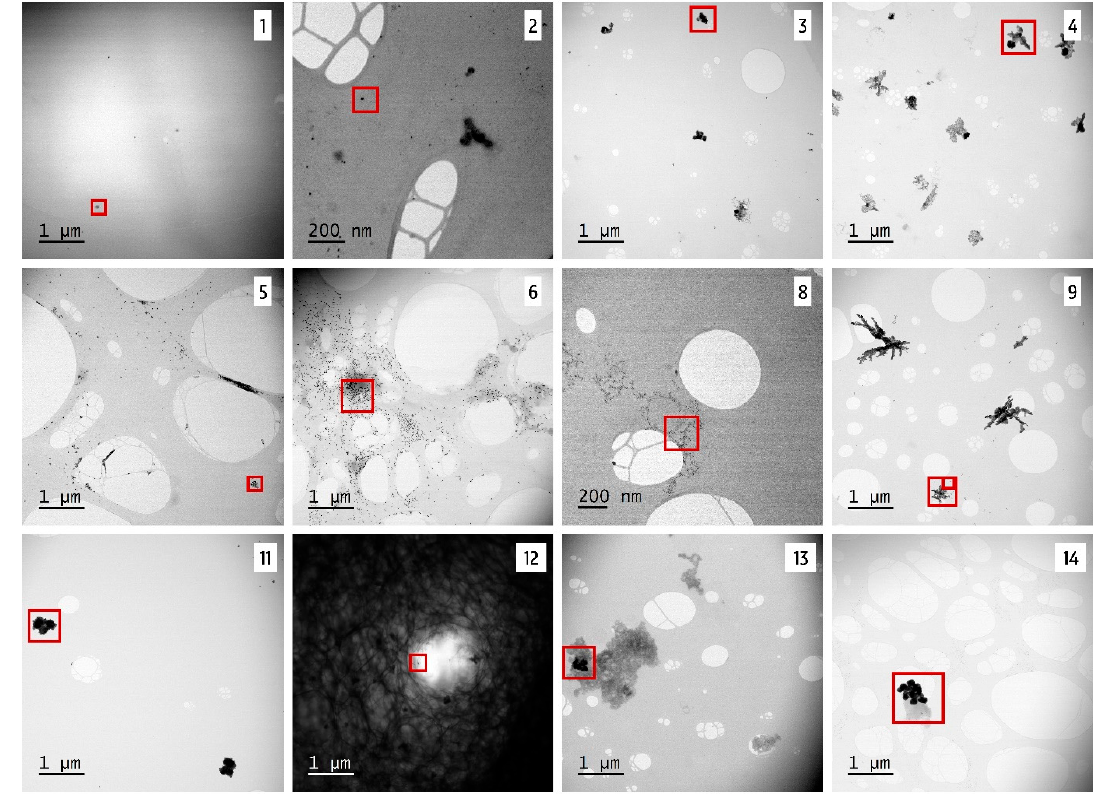
Figure 7. Representative Scanning transmission electron microscopy (STEM) images of 12 different silver products. Batch 1 is represented for products 5, 6, 8, and 9. Zoom and energy dispersive x-ray spectroscopy (EDX) of the red square can be found in Figure 8, Figure 9, and Figure 11.